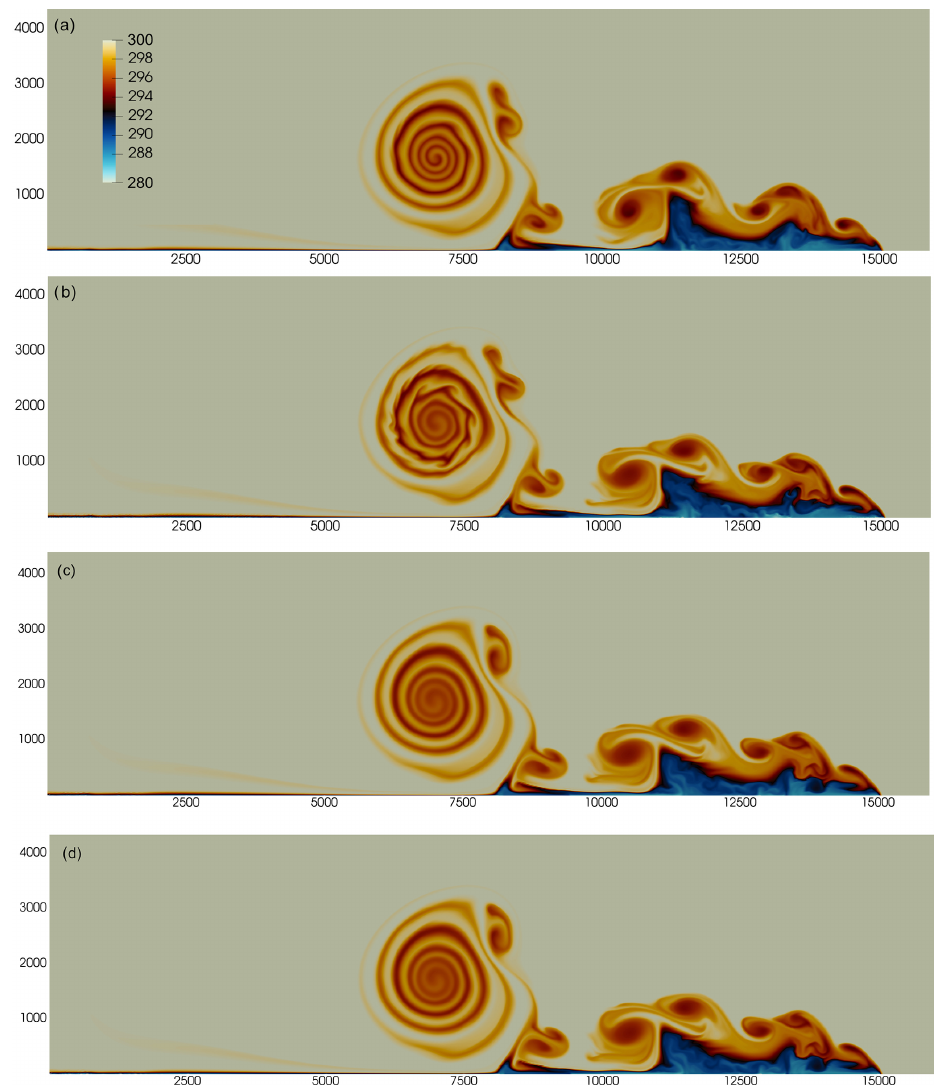
Figure 4. 2.5D density current. Potential temperature θ (K) at t = 900s computed with an effective DG resolution of (cid:49)x = (cid:49)z = 12 . 5m with domain extents shown in meters. (a) Rusanov numerical flux with SL SGS. (b) Rusanov numerical flux with Vreman SGS. (c) Roe numerical flux with Vreman SGS. (d) HLLC numerical flux with Vreman SGS. The color scale ranges from θ = 285 to 300K. A shared color bar for all plots is shown in panel (a) for